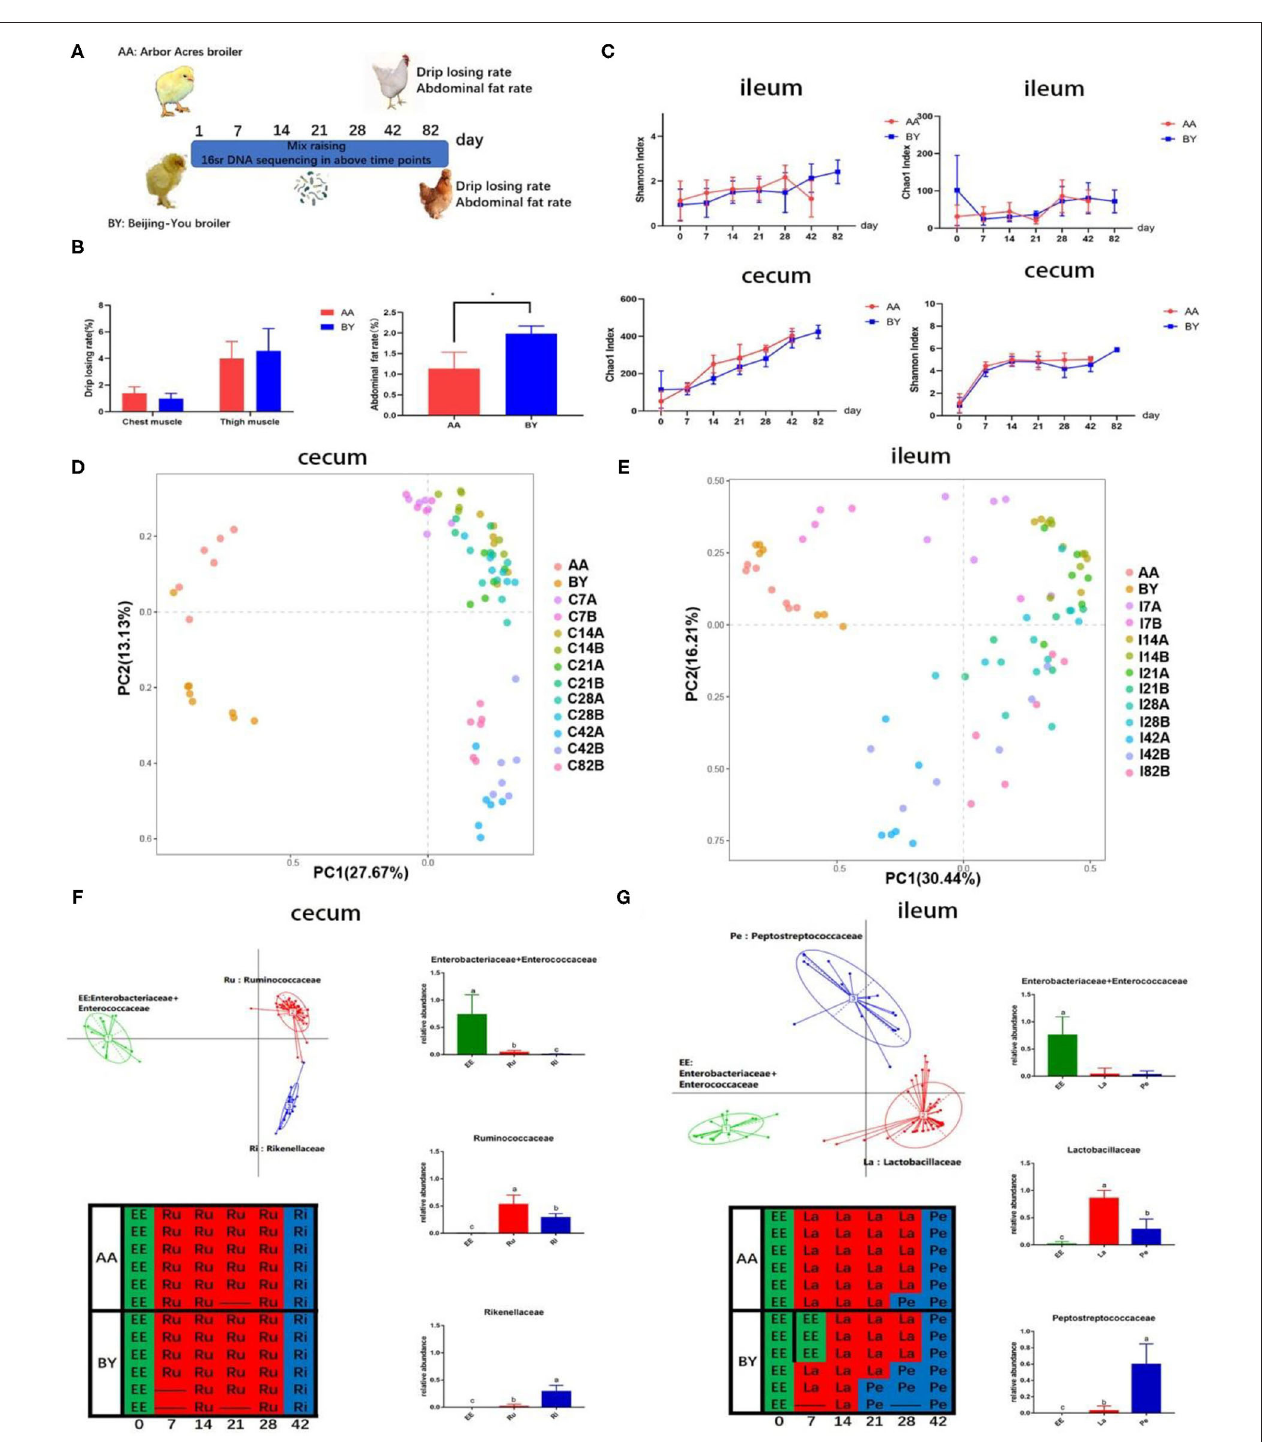
FIGURE 2 | The changes in the microbiota of the co-raised Arbor Acres broilers and the Beijing-You broilers. (A) Graph of microbiota development. (B) Abdominal fat deposition and water-holding capacity of meat in the AA broilers and the BY broilers. (C) Alpha diversity analysis of the Chao1 and the Shannon indexes in the Arbor Acres broilers and the Beijing-You broilers. Principal component analysis (PCA) of the changes in intestinal microbiota in (D) cecum and (E) Partitioning around medoid (PAM) of enterotypes in F and G. Graph: enterotypes and dominant bacteria; Table: the temporal distribution of intestinal microbiota types. The numbers of independent biological samples analyzed in panel B to H were AA ( n = 6) and BY ( n = 6) and the numbers in panels of (C–G) were AA ( n = 6) at each point and BY ( n = 6) at each point. Data in (B,C) are expressed as mean ± SEM. Data in (B,C) were analyzed using ANOVA followed by the Tukey’s test and were considered as statistically significant at * p < 0.05 between the indicated groups. Data in (D,E) were analyzed using PCA. Data in (F,G) were analyzed using PAM. Data in (D–G) statistical tests were two-sided and the differences were considered to be statistically significant at p < 0.05.